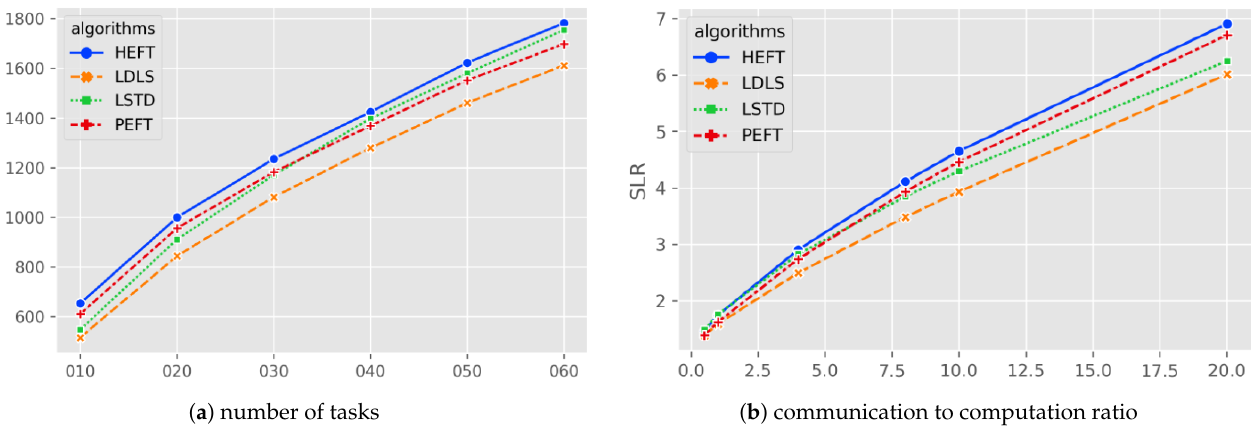
Figure 1. Average makespan /SLR for random graphs as a function of task numbers and CCR .